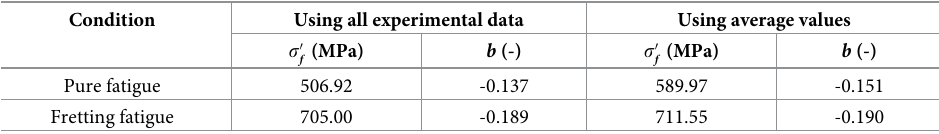
Table 2. Fatigue properties of the studied AM60 magnesium